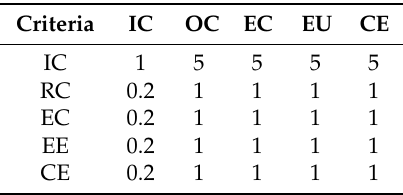
Table 4. Pair-wise comparison matrix for the five criteria.